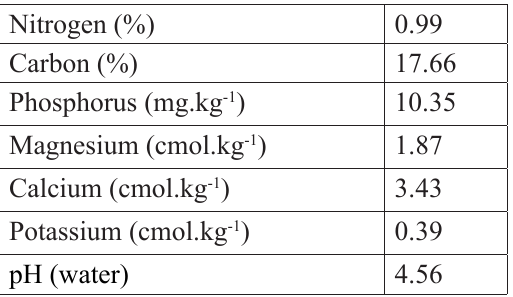
Table 1. Soil characteristics of the type